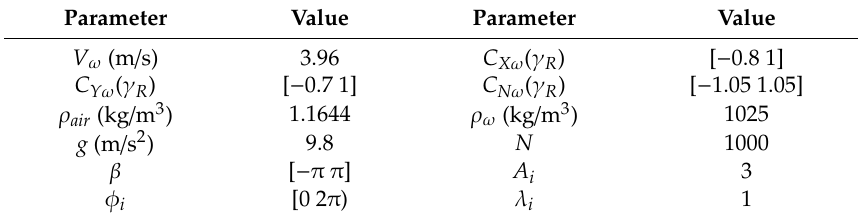
Table 3. Modeling parameters of environmental disturbances (wind, wave, and current).